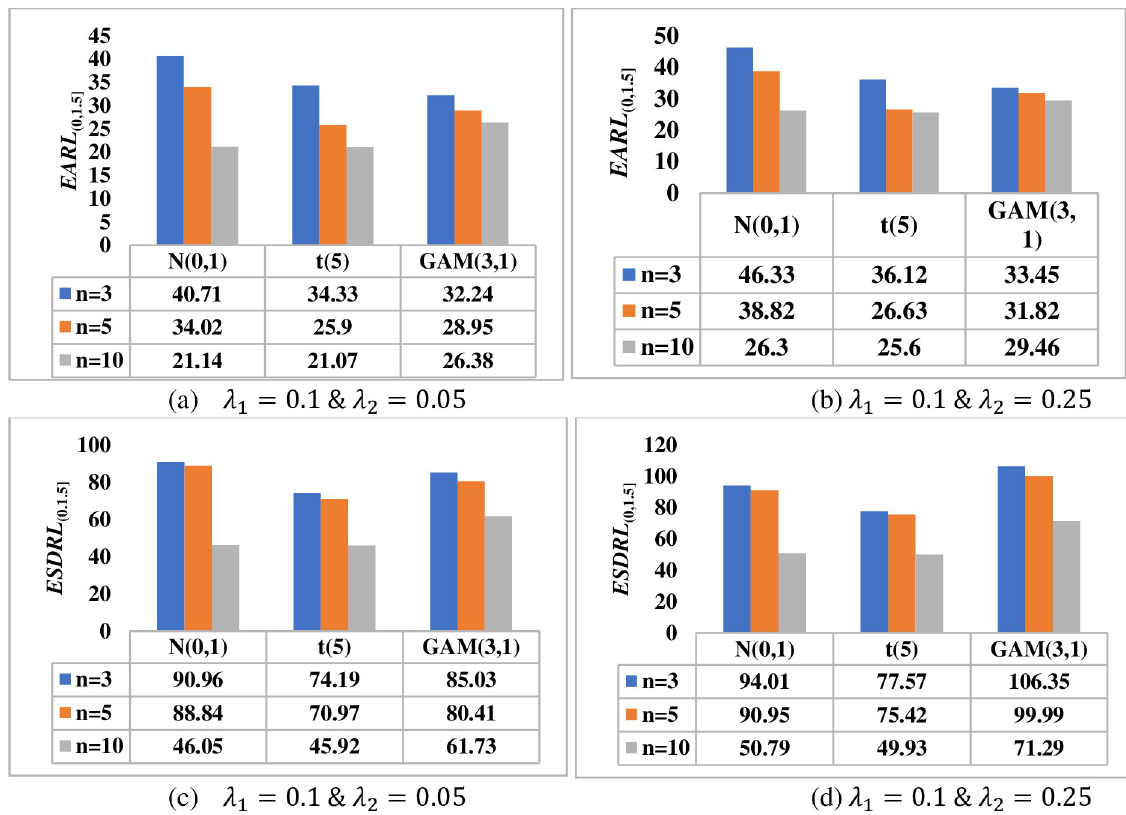
Fig 5. Effect of the phase II sample size on the performance of HHWMA W scheme when m = 100, λ 1 = 0.1, λ 2 2 {0.05, 0.25} and n 2 {3, 5, 10} under N (0,1), t (5) and GAM (3,1) distributions.